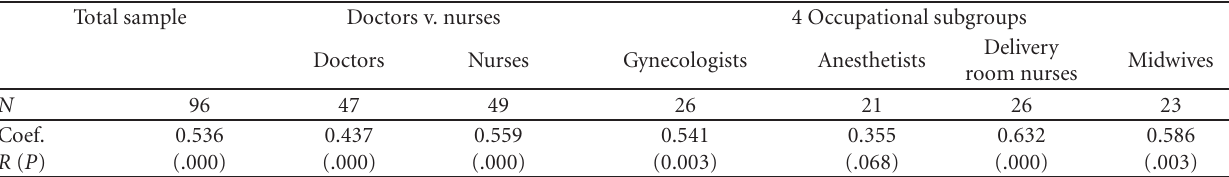
Table 3: Pearson correlation coe ffi cients between behavioral intention and perceived behavioral